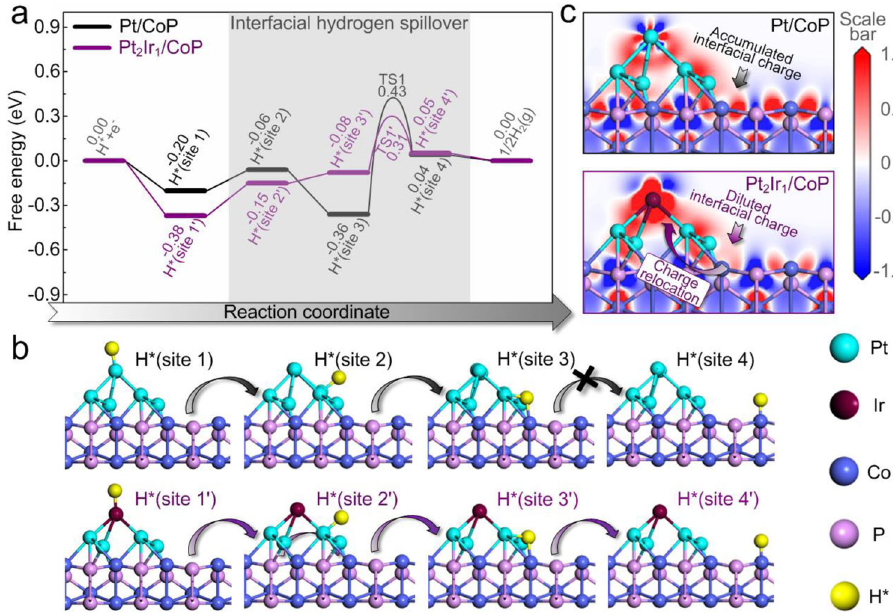
Fig. 7 Theoretical modeling. a Calculated free energy diagram for HER on Pt 2 Ir 1 /CoP paradigm and Pt/CoP benchmark. b The optimized H* adsorption structures at various sites. c Electron density difference map of interfaces, where a loss of electrons is indicated in blue and electron enrichment is indicated in